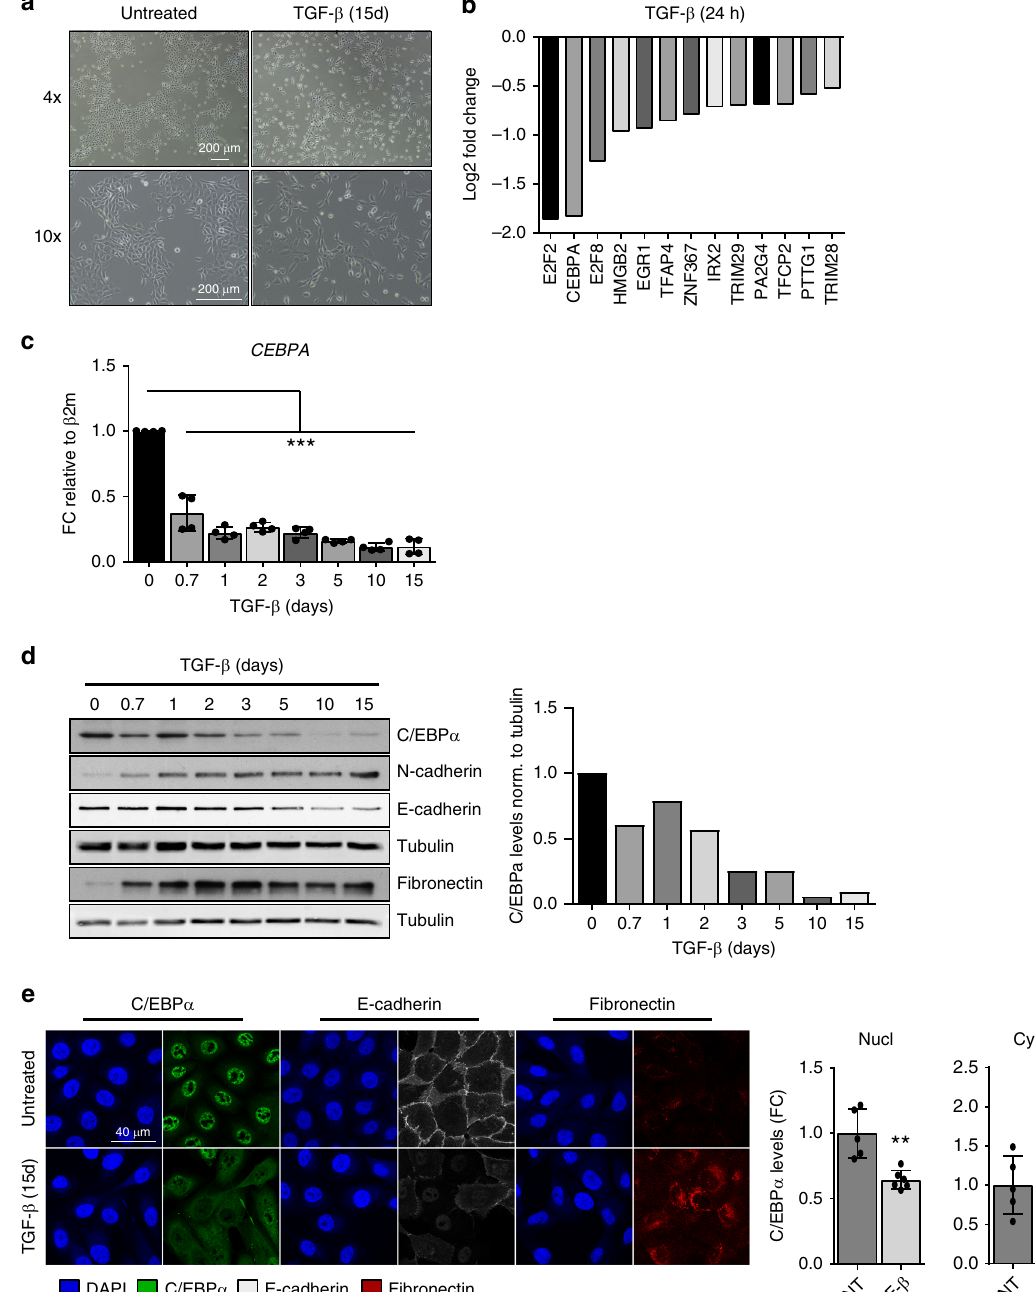
Fig. 1 C/EBP ɑ is a repressed target by TGF- β . a HMLE cells were left untreated or treated with 2.5 ng/ml of TGF- β for 15 days. Bright- fi eld microscopy images showing phenotypical changes in the presence of TGF- β signaling. Scale bar: 200 μ m. Data are representative of three independent experiments. b HMLE cells were left untreated or treated with 2.5 ng/ml of TGF- β for 24 h. RNA samples were isolated, and puri fi ed RNA was sequenced as described in “ Methods ” . Gene-ontology (GO) analysis were performed on the signi fi cant downregulated genes in HMLE treated cells. Transcription factor activity category and its log2 fold change is represented. c The results from qRT-PCR showing CEBPA mRNA expression in HMLE cells treated with 2.5 ng/ml of TGF- β as indicated. Data are represented as mean ± SD of four independent experiments. p -values were calculated using unpaired two-tailed Student ’ s t test. *** p < 0.001. d The results from immunoblotting analysis showing the effect of TGF- β treatment on C/EBP ɑ protein levels and established EMT markers in HMLE cells. Quanti fi cation of C/EBP α protein levels normalized to tubulin are shown. Data are representative of three independent experiments. e Immuno fl uorescence staining of C/EBPa and well-characterized EMT markers upon 15 days of TGF- β treatment in HMLE cells. Quanti fi cation of C/EBP α nuclear (nucl) and cytoplasmic (cyto) expression levels in untreated and TGF- β -treated cells is shown. Data represented as mean ± SD of fi ve (untreated) and six (TGF- β ) independent experiments. p -values were calculated using unpaired two-tailed Student ’ s t test. * p < 0.05, ** p < 0.01. d days, h hours, FC fold change, β 2m beta-2-microglobulin, UNT